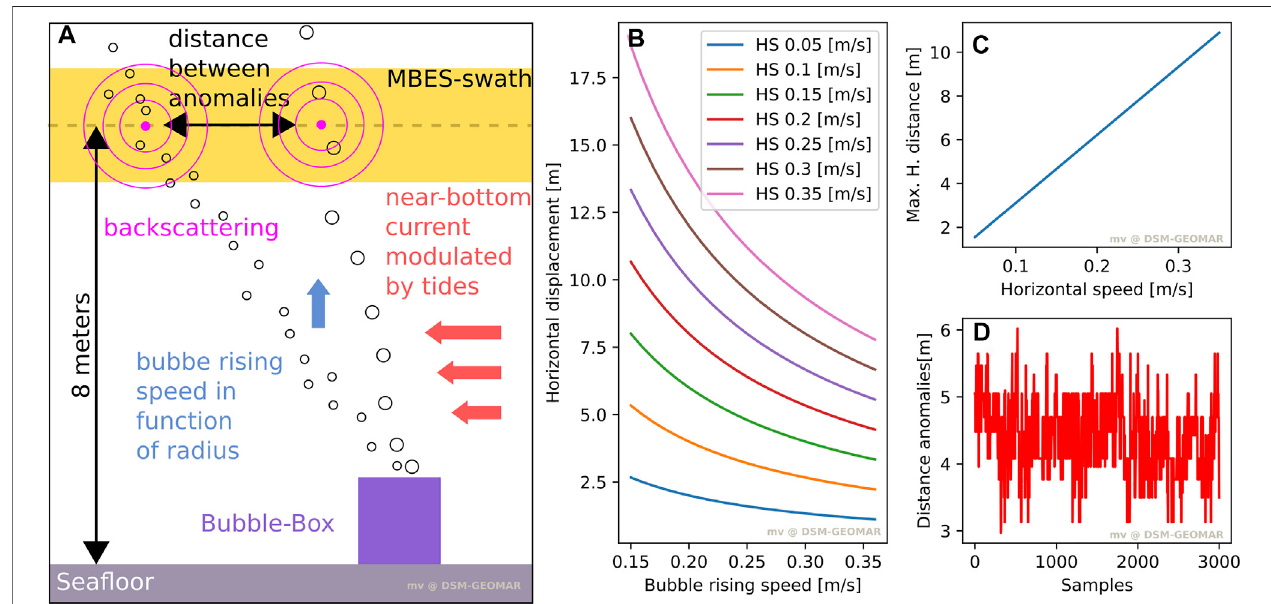
FIGURE 11 | (A) Schematic of hypothesis of separation of ascending bubbles by different sizes under the effect of near-bottom currents. The image includes the MBES-swath (yellow rectangle) ensonifying two bubble streams with differently sized bubbles coming from the same bubble outlet at the sea fl oor. (B) Horizontal displacementofbubbleswithdifferentrisingspeeds(between15and37 cm/s)Thecalculationisdonefornear-bottom currents(HS) rangingfrom 0.05to0.35 m/sand ariseheightof8 m. (C) Linearrelationshipbetweenhorizontalcurrentspeeds andmaximum displacement(slowestbubbles) at aheightof8 mabove thesea fl oor. (D) Distance between the acoustic anomalies An7 and An7 ′ over time (mean value ~4.4